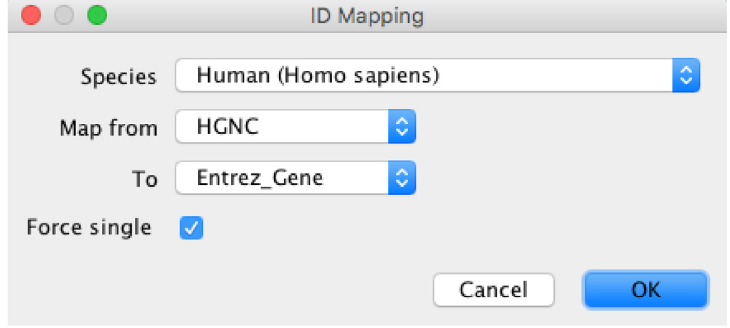
Figure 1. Simplified dialog for ID Mapping. Four options are presented to the user when accessing idmapper from within the Cytoscape GUI, each with common default or inferred values to reduce the number of steps required of the